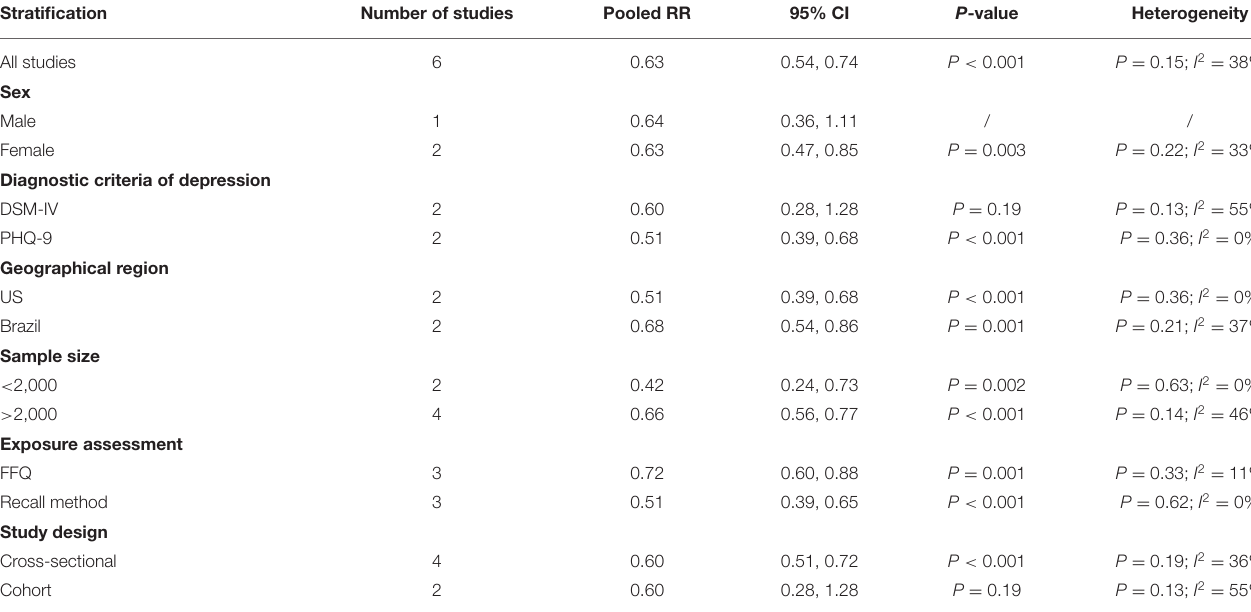
TABLE 3 | Subgroup analysis of depression for the highest vs. lowest dietary selenium intake